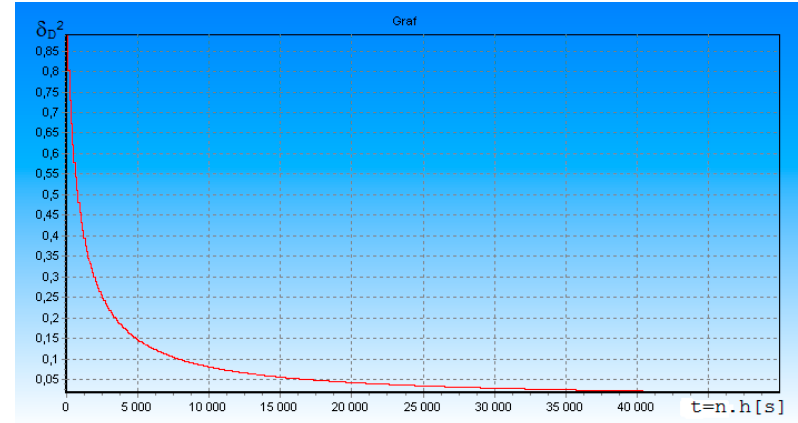
Figure 2. Dependence of the δ D2 of standardized measurement error of the slant range D(t) between FO (Flying Object) and distance-measuring equipment (DME), on time t = 0 to 0.05 s.